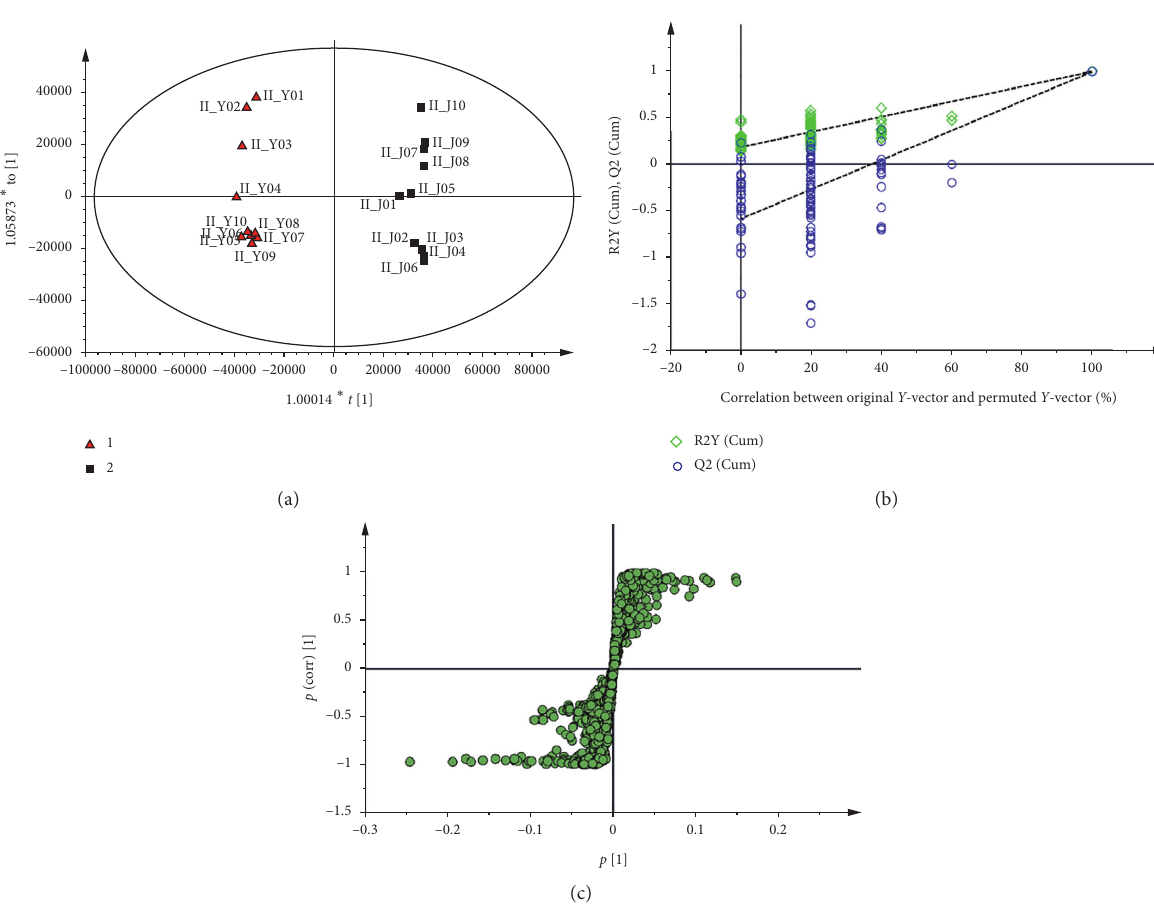
Figure 3: The OPLS-DA/permutation test/S-plot of white ginseng and extruded white ginseng in negative ion